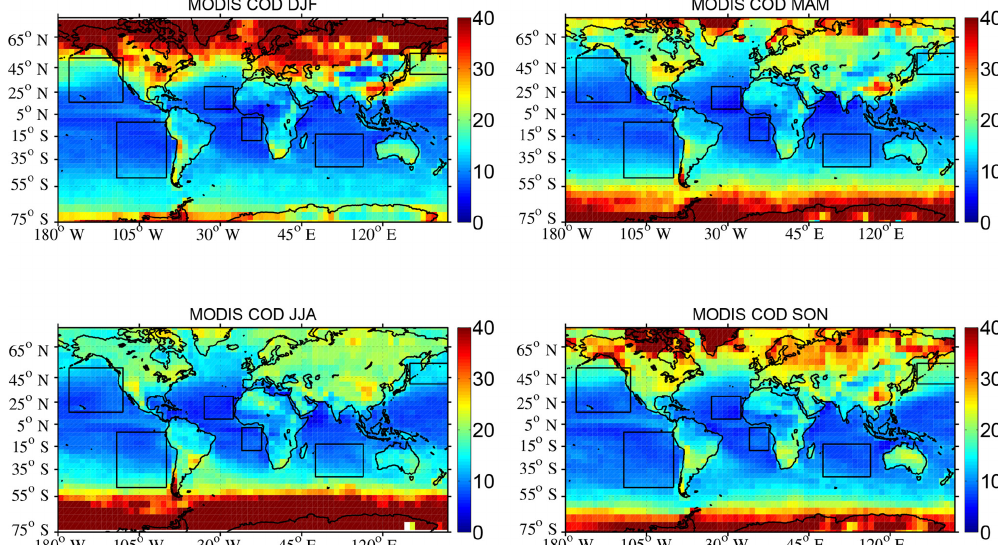
Figure A2. Seasonal maps of COD used in the calculations of DARE OWC . COD information is inferred from MODIS seasonally averaged monthly 1 ◦ × 1 ◦ grids (i.e., liquid water cloud products of MYD08_M3: “Cloud Effective Radius Liquid Mean Mean” and “Cloud Optical Thickness Liquid Mean Mean”; Platnick et al., 2015) from 2008 to 2012. The squares show different regions defined in Table 5.